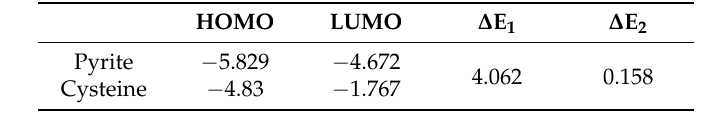
4B Figure 3. The optimized configuration of cysteine adsorbed on the pyrite (1 0 0), showing with -SH ( 1A / 1B ), -NH 3 ( 2A / 2B ), =O (-C=O, 3A / 3B ), -O (-C-OH, 4A / 4B ) of cysteine adsorbed on the S/Fe site of pyrite (1 0 0), respectively.